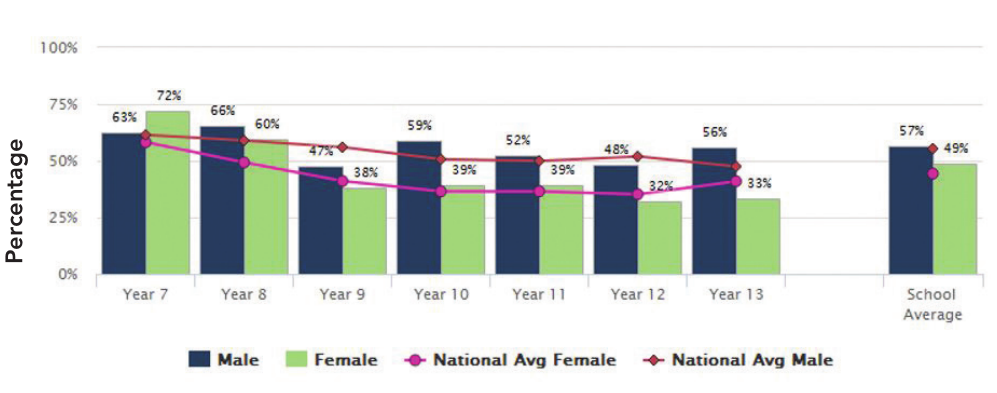
Figure 2: Sample chart from a Student Health and Well-being Report showing percentage of students who eat breakfast every